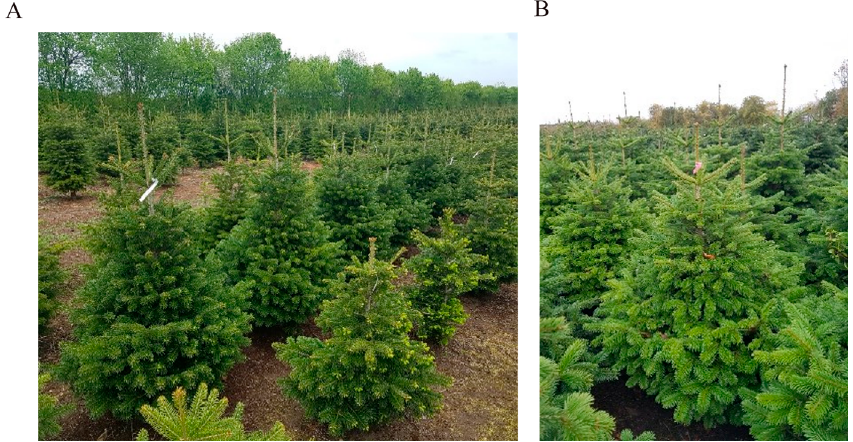
Figure 6. Photos showing naturally grown clones in demo-planting at Holstebro site after 6 growing seasons. ( A ) The image shows a standard, well-performing clone, and shows in front a slow-growing clone of poor quality. ( B ) Good-performing clone 42.02 after 7 seasons.